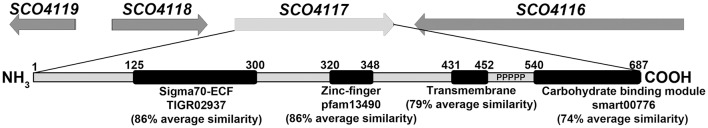
SCO4117 structure. Outline of the SCO4116-SCO4119 region, showing the SCO4117 conserved domains and average similarities between SCO4117 and their orthologs in S. griseus, S. avermitillis, S. lividans, S. clavuligerus, and S. venezuelae. Ps indicate the proline-rich C-terminal extension.